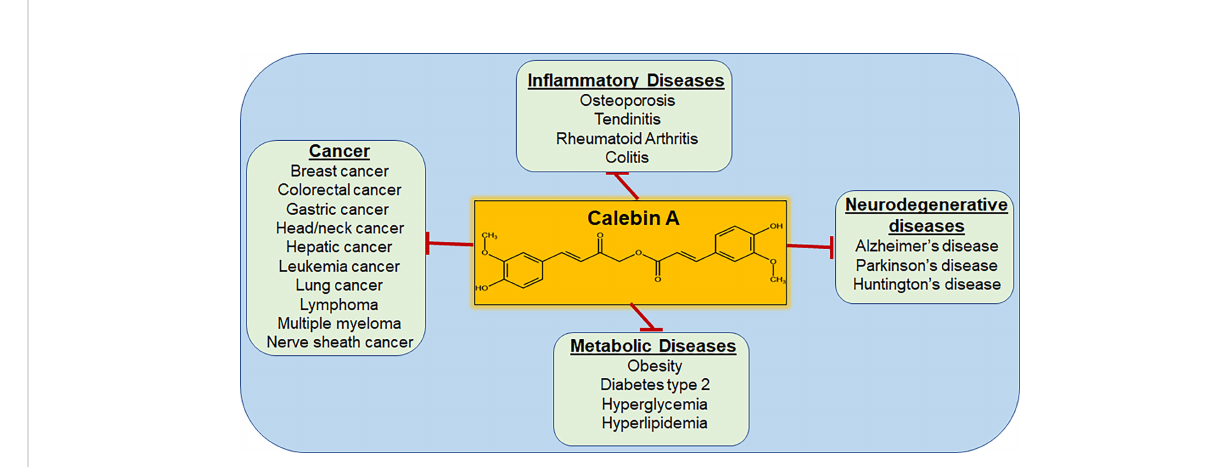
FIGURE 5 Diseases that are targeted by Calebin A. As a multi-target molecule, Calebin A may play a regulatory role in various diseases, including